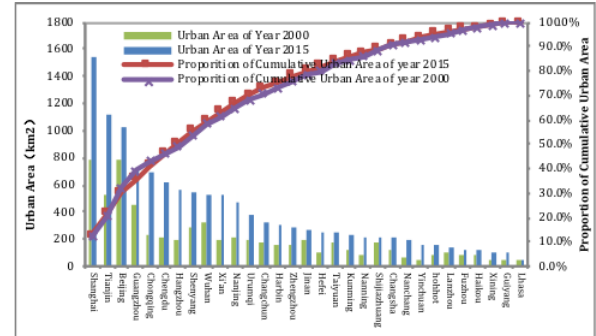
Figure 5. Urban area and the change from year 2000 to